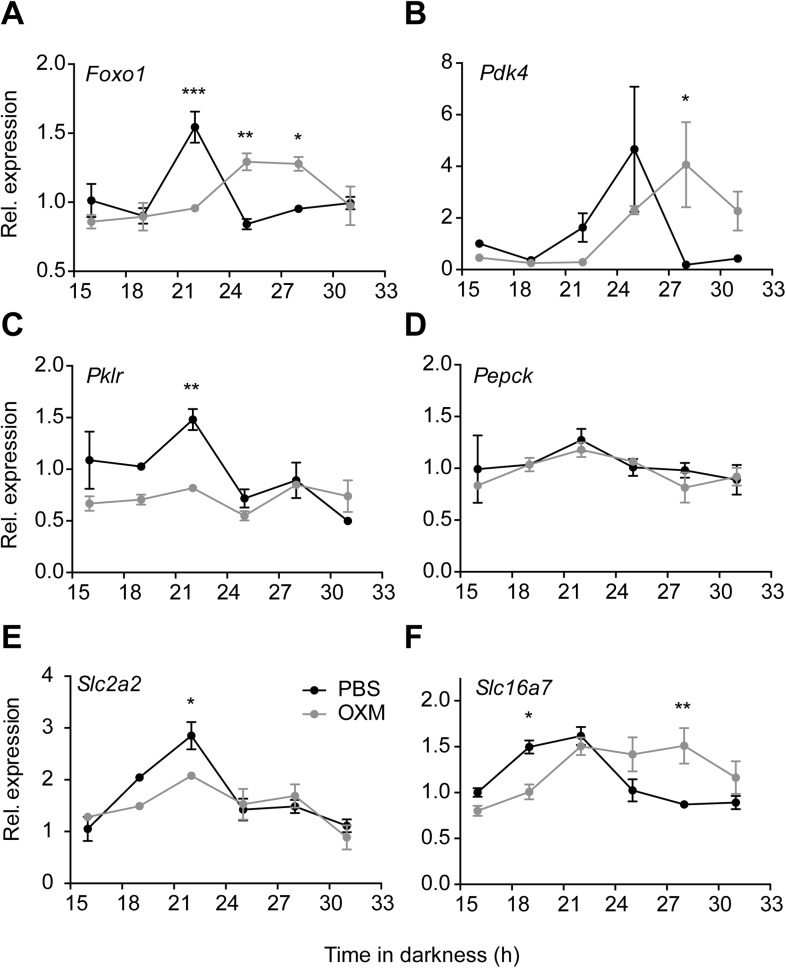
OXM treatment modulates diurnal expression profile of hepatic genes involved in liver carbohydrate metabolism.(A–F) Relative gene expression of Foxo1 (A; factor treatment F(1, 24) = 0.001, time F(5, 24) = 5.547, interaction F(5, 24) = 11.13), Pdk4 (B; factor treatment F(1, 24) = 0.197, time F(5, 24) = 3.35, interaction F(5, 24) = 3.247), Pklr (C; factor treatment F(1, 24) = 11.63, time F(5, 24) = 5.61, interaction F(5, 24) = 3.61), Pepck (D; factor treatment F(1, 24) = 0.574, time F(5, 24) = 2.043, interaction F(5, 24) = 0.299), the glucose transporter Slc2a2 (E; factor treatment F(1, 24) = 2.582, time F(5, 24) = 15.98, interaction F(5, 24) = 2.642) and the pyruvate transporter Slc16a7 (F; factor treatment F(1, 24) = 1.539, time F(5, 24) = 7.472, interaction F(5, 24) = 6.586) after i.p. administration of either OXM (grey) or vehicle (PBS; black) after 12 hr in darkness. Data are presented as mean ± S.E.M. (n = 4). Two-way ANOVA with Bonferroni post-test: *p < 0.05, **p < 0.01; ***p < 0.001.